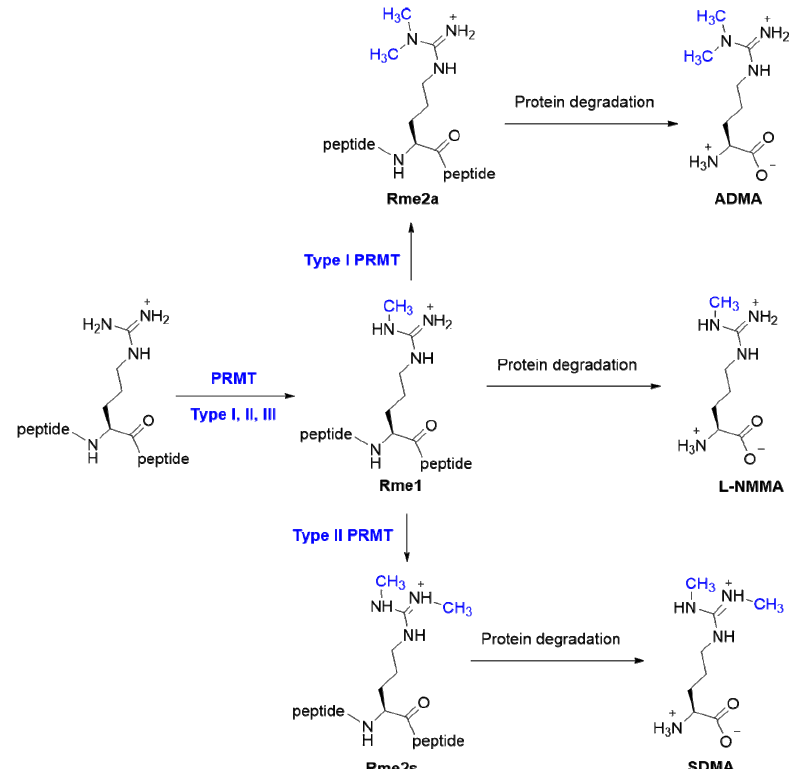
Figure 1. The biological axis of protein arginine methylation and formation of methylarginine small molecule metabolites. Type I, II, and III PRMTs catalyze the initial monomethylation of an arginine residue at the terminal guanidinium nitrogen. Subsequently, type I and II can catalyze a second arginine methylation reaction to form the asymmetric and symmetric dimethylated arginine residues, respectively. Protein degradation of arginine methylated proteins produces the ADMA, l -NMMA, and SDMA